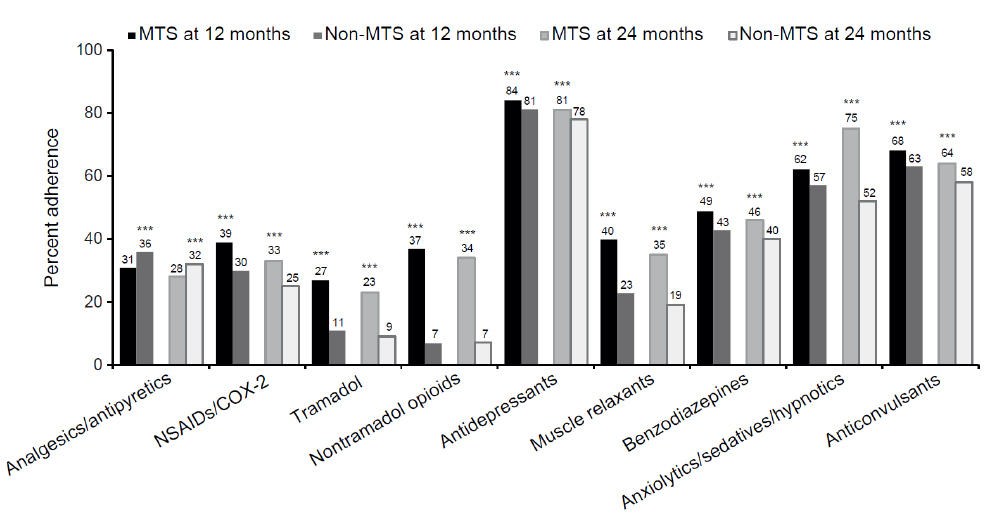
PDC of prescribed oral pain medications at 12 and 24 months in the propensity-matched OA cohorts initiating a medication within 30 days post- index (n=186 374 per